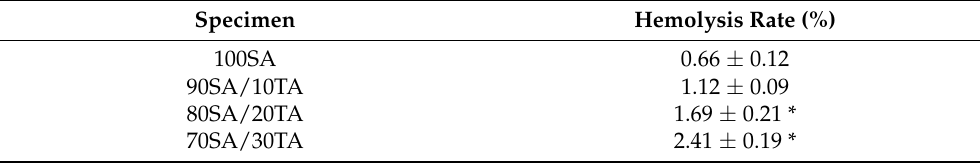
Table 3. Hemolysis rate for each type of film in contact with blood films (n = 5; * significantly different from 100SA— p <